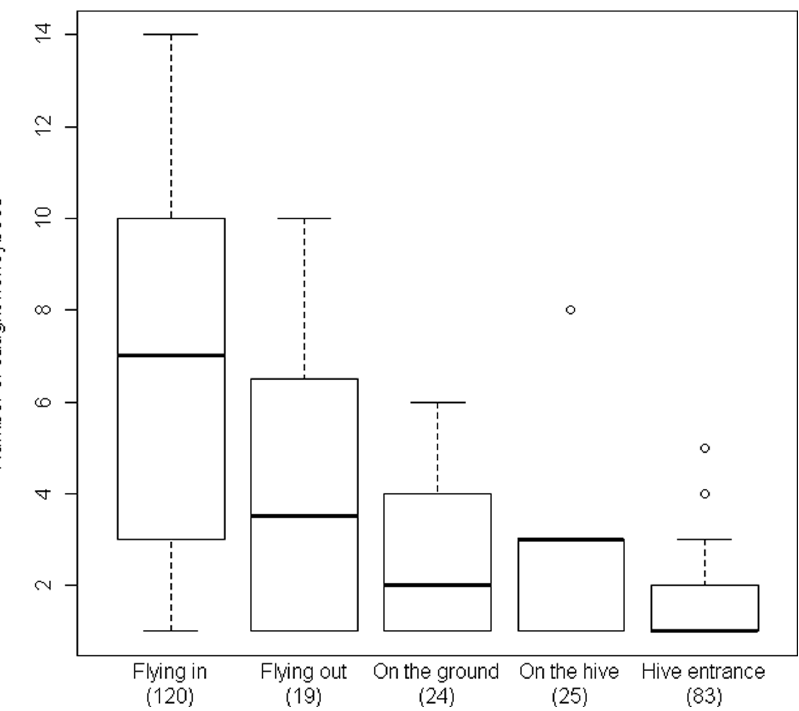
Figure 2. Distribution of the honeybees caught by Vespavelutina . The data are pooled for H1 and H2. Boxes, plain line, dashed lines, and open circles represent 50% of all values, medians, 1.5 interquartile range and extreme values respectively. Sample sizes for each location are presented in parentheses.